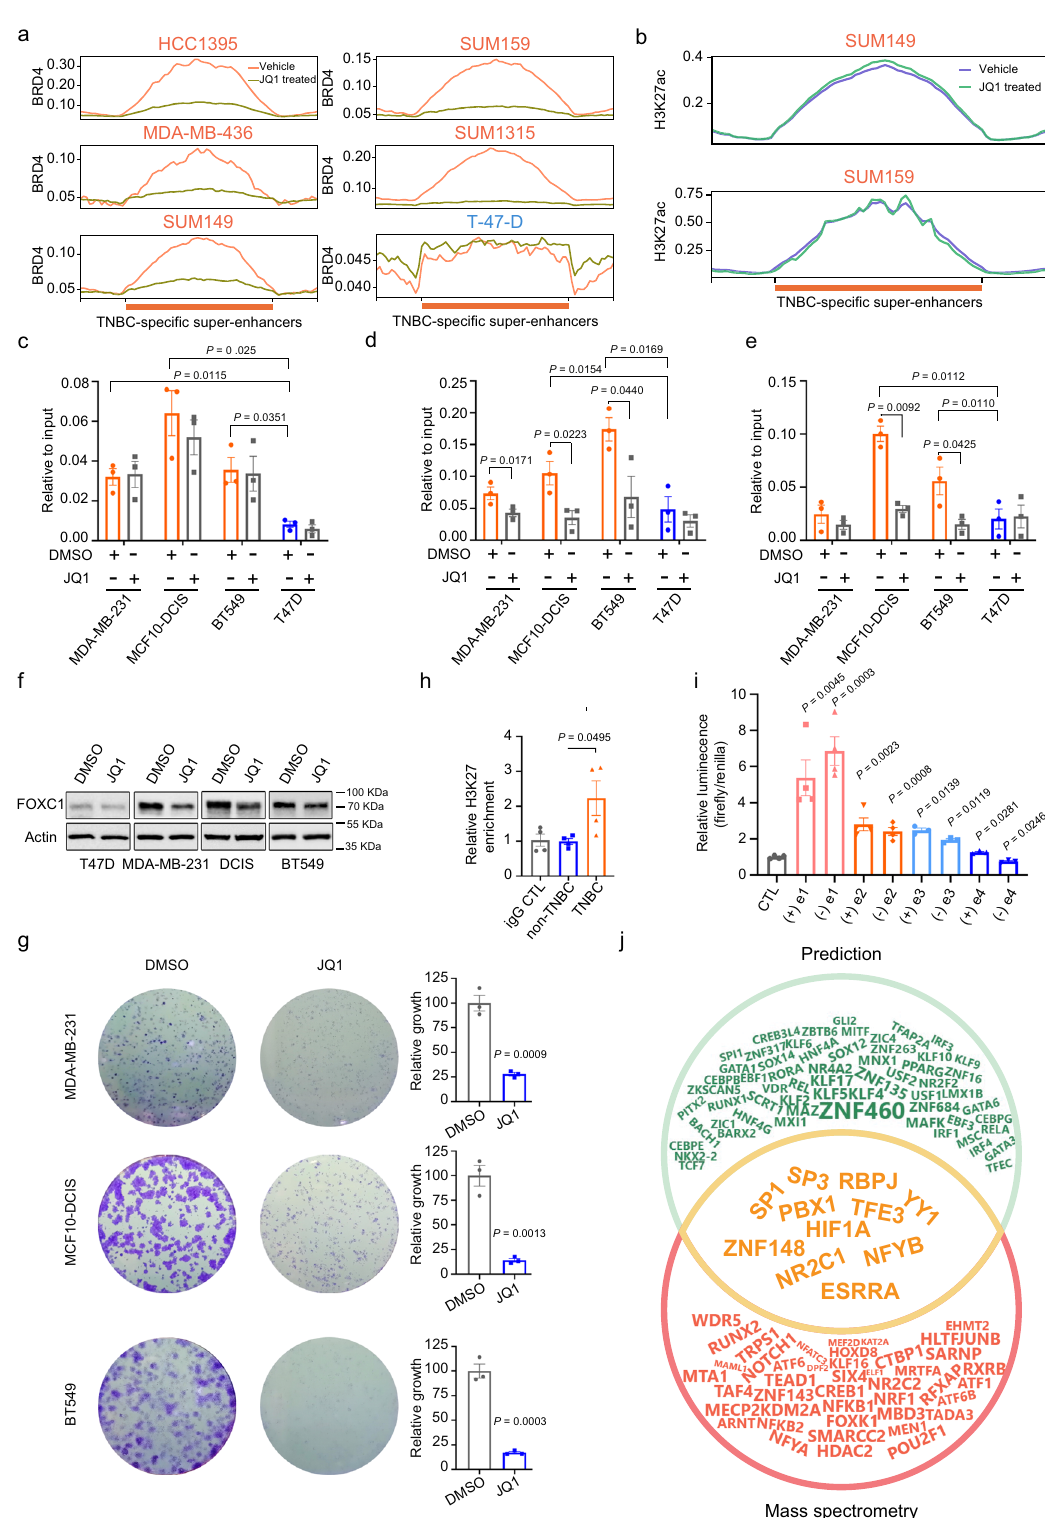
(Supplementary Table 1) with Hi-C data for TN line MCF-10A and non-TNBC line MCF7 to investigate whether the SEs are looping to the promoters of their putative target genes. As the data are too sparse (MCF-10A: 169,655,013 contacts; MCF7: 165,433,519 contacts), we could not identify any signi fi cant